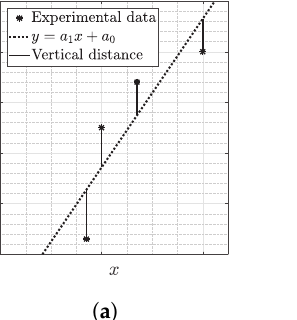
Figure 1. Straight line fitting problem. ( a ) Classic least squares algorithm.; ( b ) Least squares of orthogonal distances